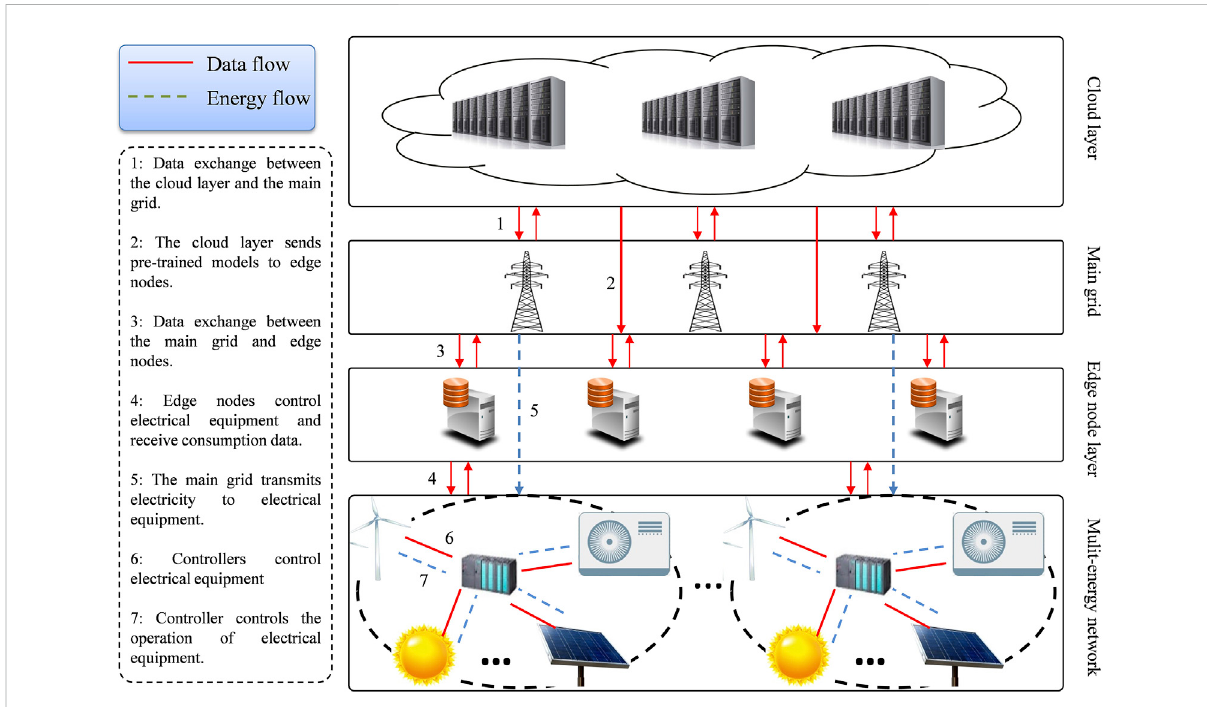
FIGURE 1 Framework of STLF system based on edge computing. 1: Data exchange between the cloud layer and the main grid; 2: The cloud layer sends pre-trained models to edge nodes; 3: Data exchange between the main grid and edge nodes; 4: Edge nodes control electrical equipment and receive consumption data; 5: The main grid transmits electricity to electrical equipment; 6: Controllers control electrical equipment; 7: Controller controls the operation of electrical equipment.